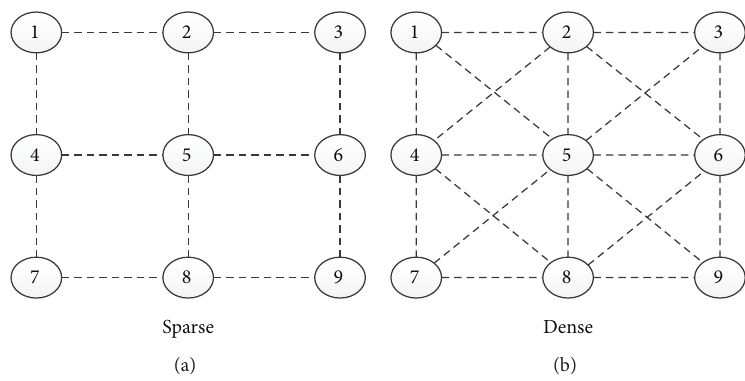
Figure 3: Experiment topologies: spare and dense models.